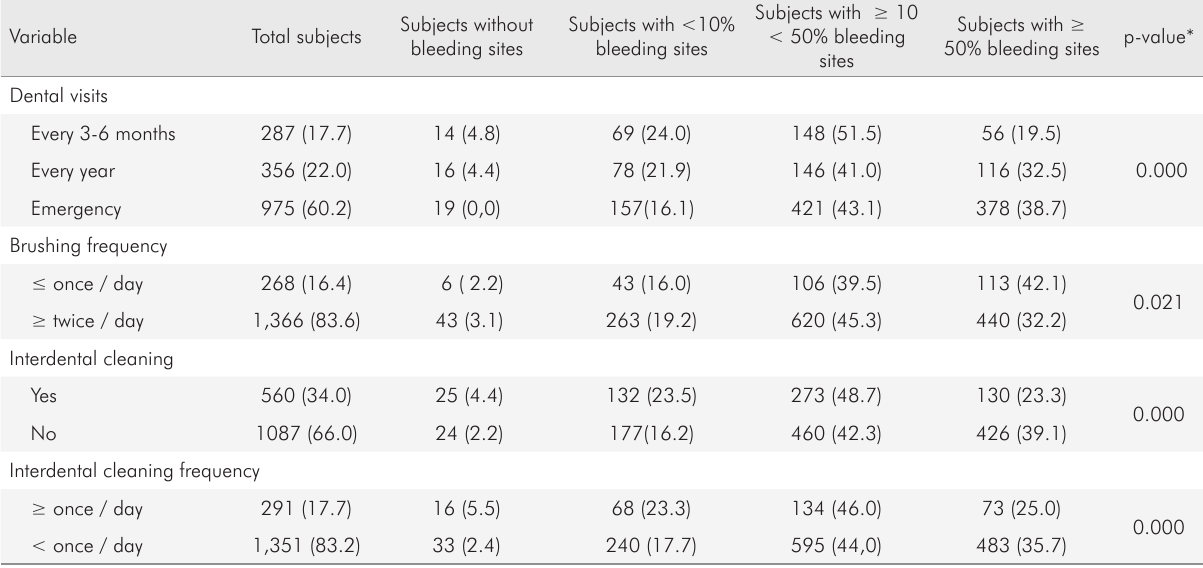
Table 5. Oral health behavior variables by prevalence of gingival bleeding: Distribution of subjects (n and %) according to bleeding site frequency (GI 2+3).